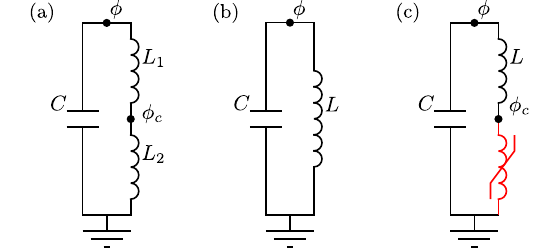
FIG. 2. (a) Series combination of two linear inductances L 1 and L 2 with a shunting capacitance C , and (b) the effective equivalent LC circuit obtained by eliminating the constrained variable and adding the inductances L ¼ L 1 þ L 2 . (c) Series combination of a linear inductance L and a nonlinear inductor (red) with a shunting capacitance C